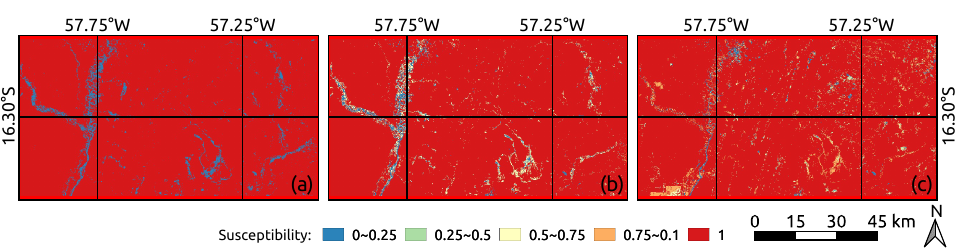
Figure 9. Fire susceptibility maps for Area 1 with OC-SVM method as anomaly detection model. Subfigures ( a – c ) refer to mappings based on the “analysis period” of epochs I, II, and III, respectively.